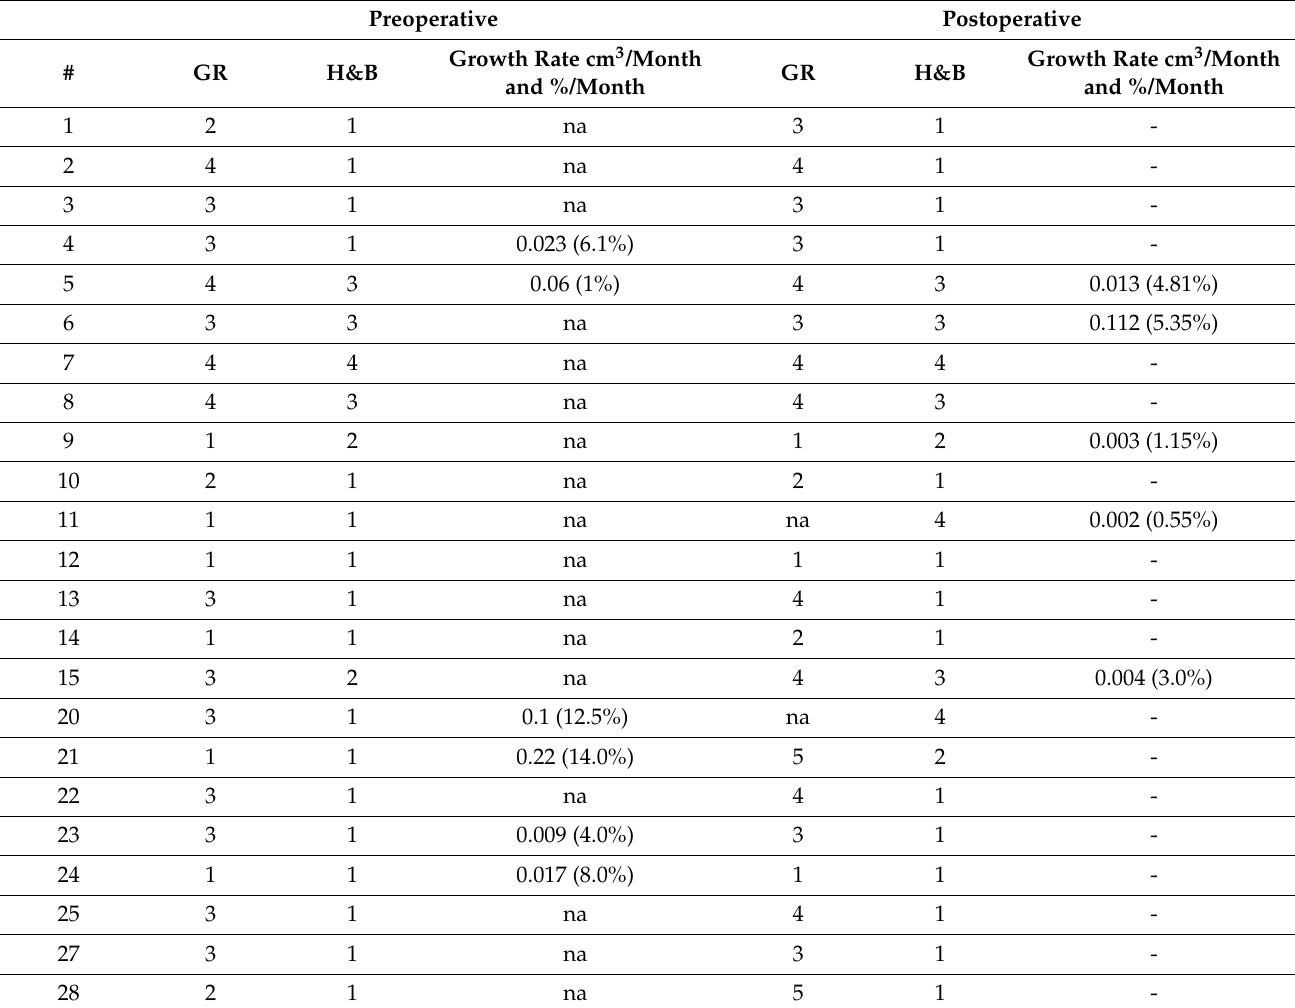
Comparison of pre- and post-operative hearing, facial nerve function and tumor growth